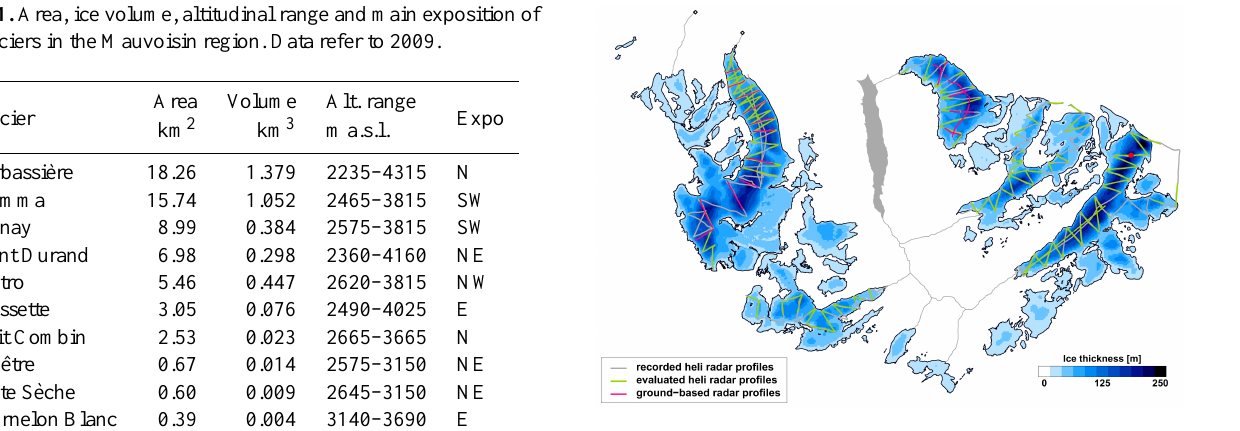
Fig. 2. Ice-thickness distribution in the Mauvoisin region derived by all available ice-thickness measurements. Glacier outlines refer to 2009. The grey lines show the recorded helicopter-based GPR profiles, the green lines the finally evaluated profiles and the red lines the ground-based GPR profiles from previous field campaigns. The red dot refers to the GPR section shown in Fig.